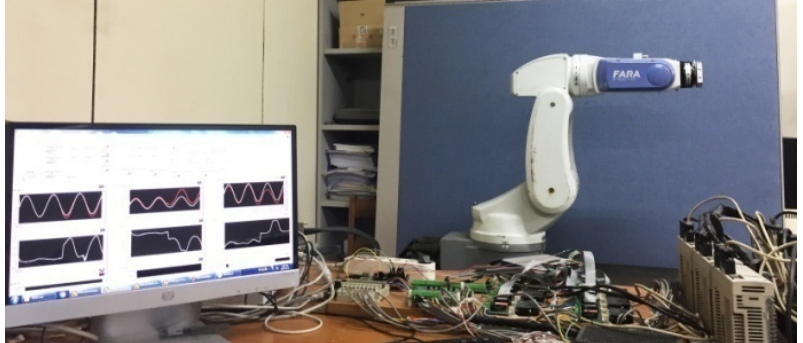
Figure 9. The experimental setup with FARA-AT2 Robot Figure 3. A real FARA-AT2 robot system